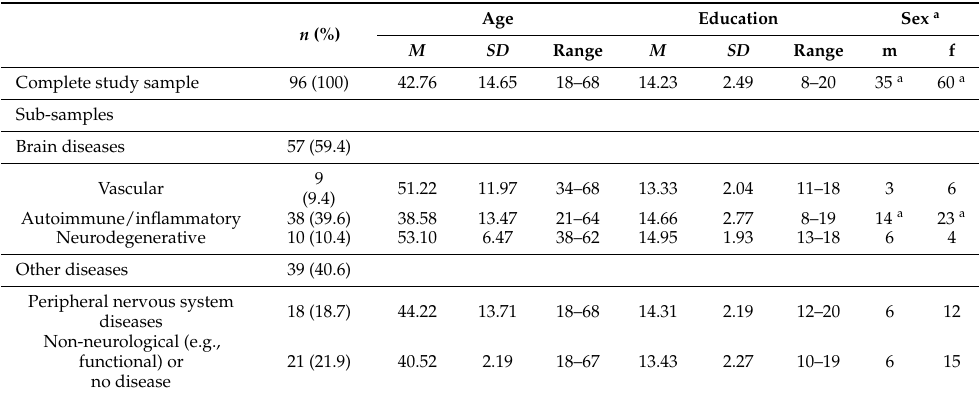
Table 1. Sociodemographic sample